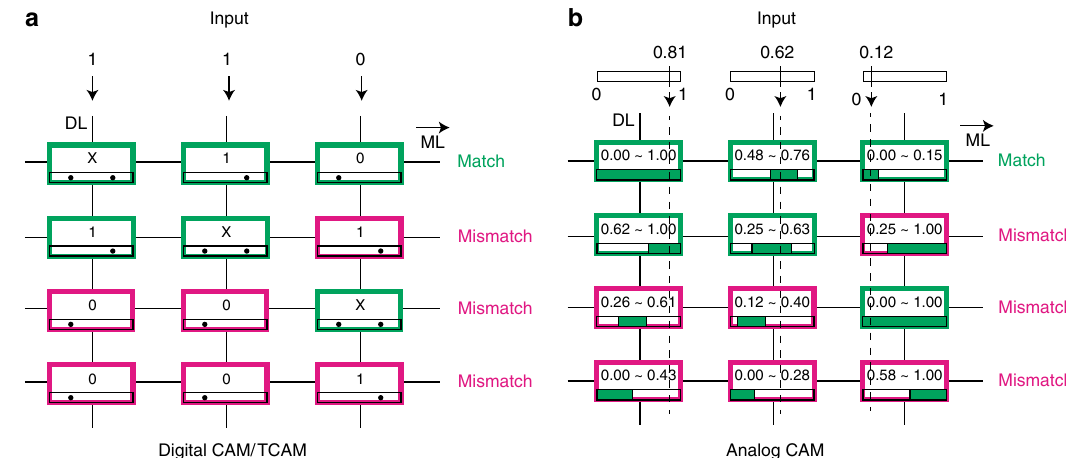
Fig. 1 Schematic of the memristor analog content-addressable memory concept. a A digital content-addressable memory (CAM) compares the input word against all stored words or rows in parallel. Ternary CAM (TCAM) is an extension where in addition to search/stored “ 0 ” and “ 1 ” values, “ X ” is a wildcard that always yields a match. Data are searched along vertical Data Lines (DL) and the binary match result of the compare operation between searched and stored words in each row is sensed on horizontal Match Lines (ML). The CAM returns the match location of stored data and the searched input ( fi rst row here). b The analog CAM searches and stores analog data, where the input data can be a continuous value, and the stored data are a continuous interval with a lower and upper bound representing an acceptance range for a